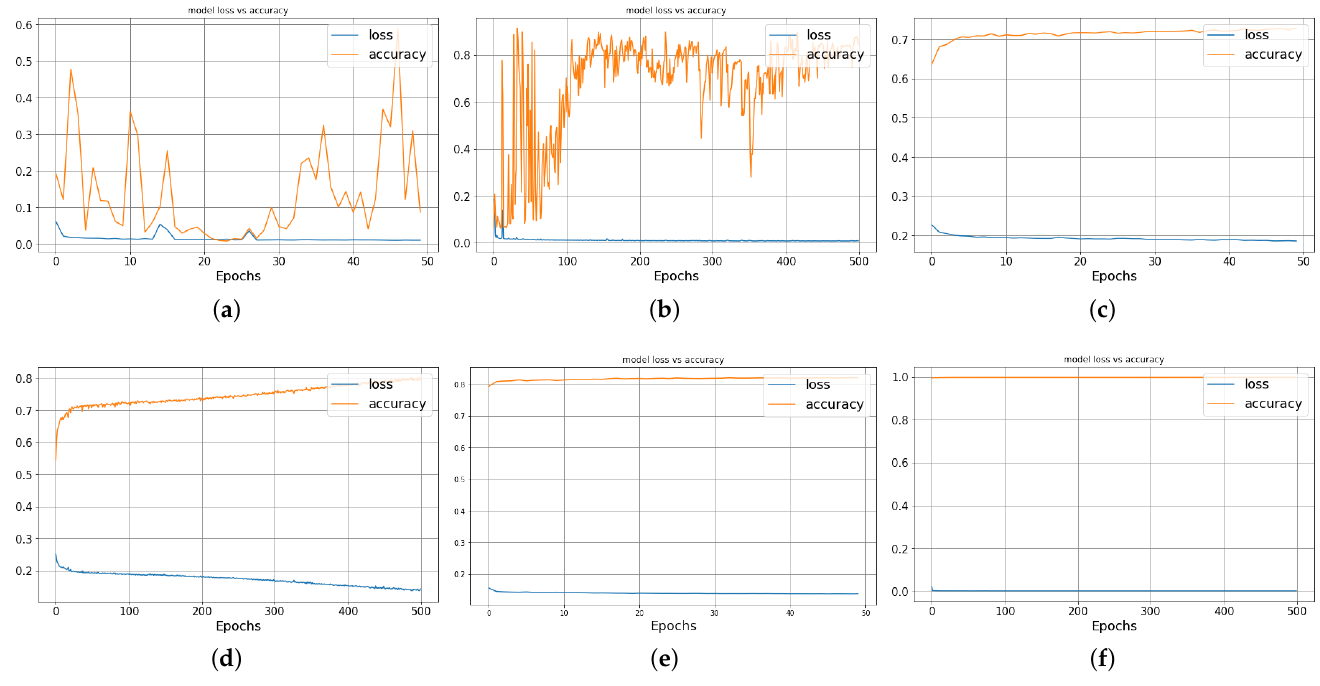
Figure 8. Performance of AI algorithm based on datasets 1 and 2. ( a ) 50 epochs LSTM RMSprop optimizer of dataset 1. ( b ) 500 epochs LSTM RMSprop optimize of dataset 1. ( c ) LSTM 50 Epochs RMSprop Optimizer of dataset 2. ( d ) LSTM 500 Epochs RMSprop Optimizer of dataset 2. ( e ) LSTM and XAI model on 50 epochs of CC-FF dataset. ( f ) LSTM and XAI model on 500 epochs of CC-